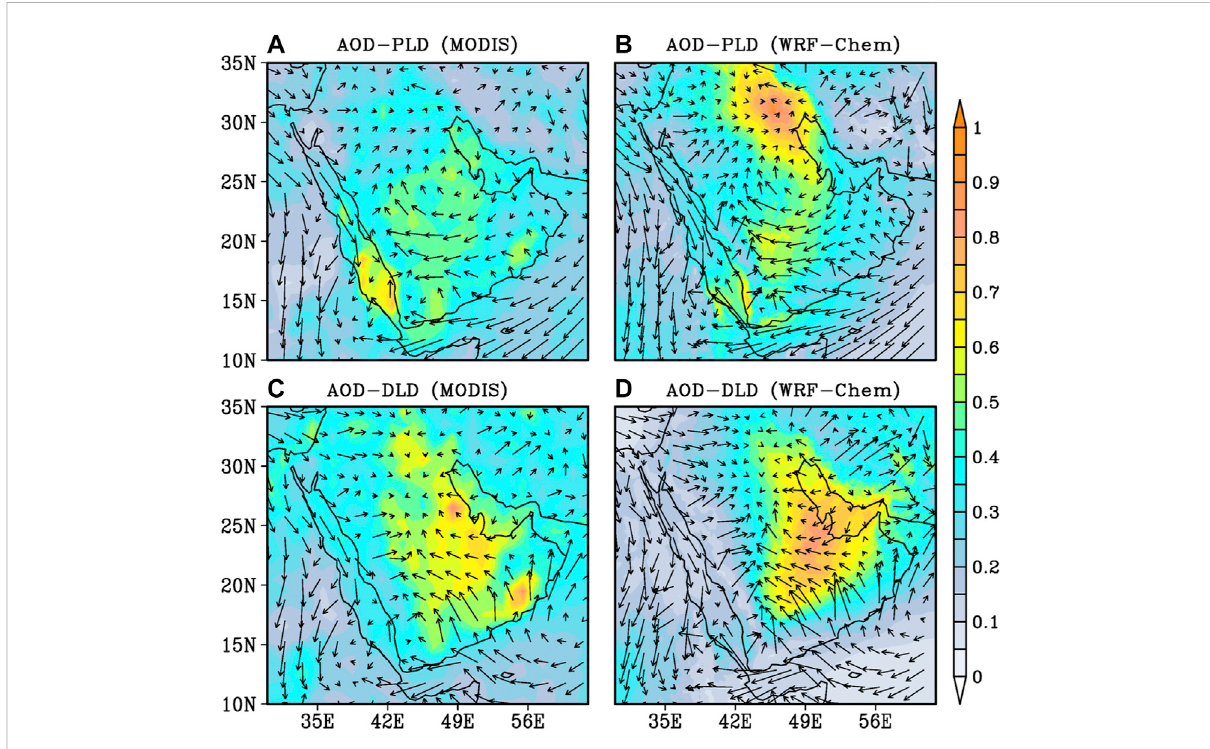
FIGURE 5 Time averaged spatial distribution of AOD over AP obtained from MODIS overlaid with surface winds from ERA-5 reanlysis, during (A) PLD and (C) DLD periods, (B) and (D) are the same as (A) and (C) , but simulated by WRF-Chem